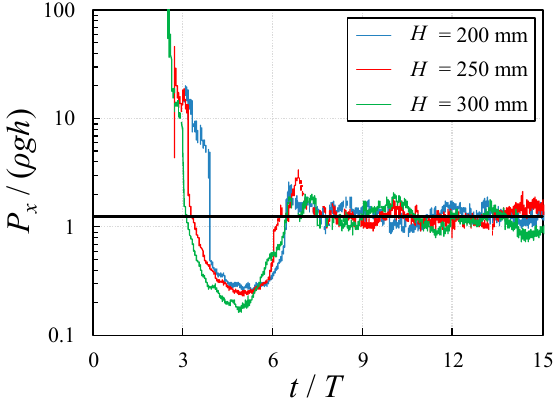
Figure 10. Non-dimensionalized time-history of the ratio of dynamic pressure to instantaneous wave hydrostatic pressure for different impoundment depths. Pressure data from transducer 1.